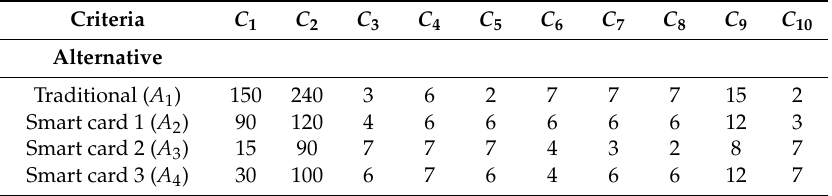
Table A4. Initial decision matrix filled by DM4 for WASPAS analysis.